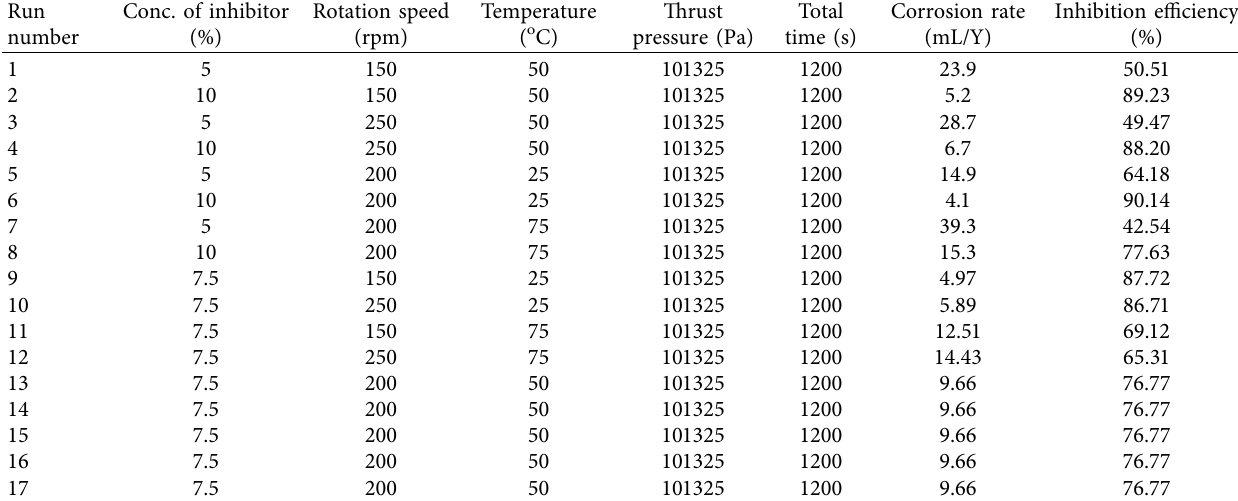
Table 2: Corrosion rate and inhibition efficiency of steel alloy 4130 in 3.5 wt.% NaCl using LI as an